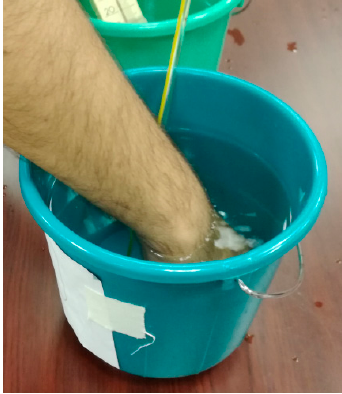
Figure 3. Submerging in cold water bowl (5 °C).